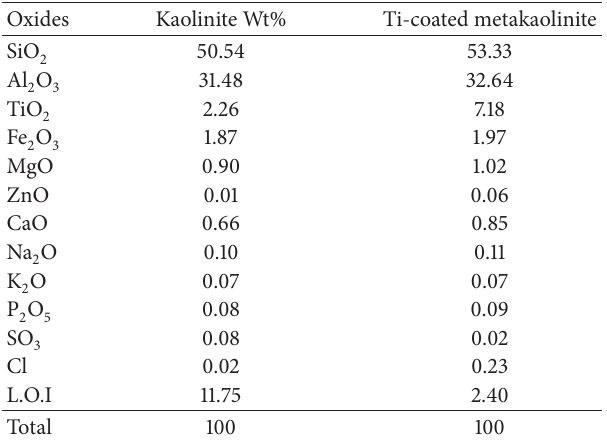
Table 2: Chemical analysis of the starting Kaolinite and Ti-treated form